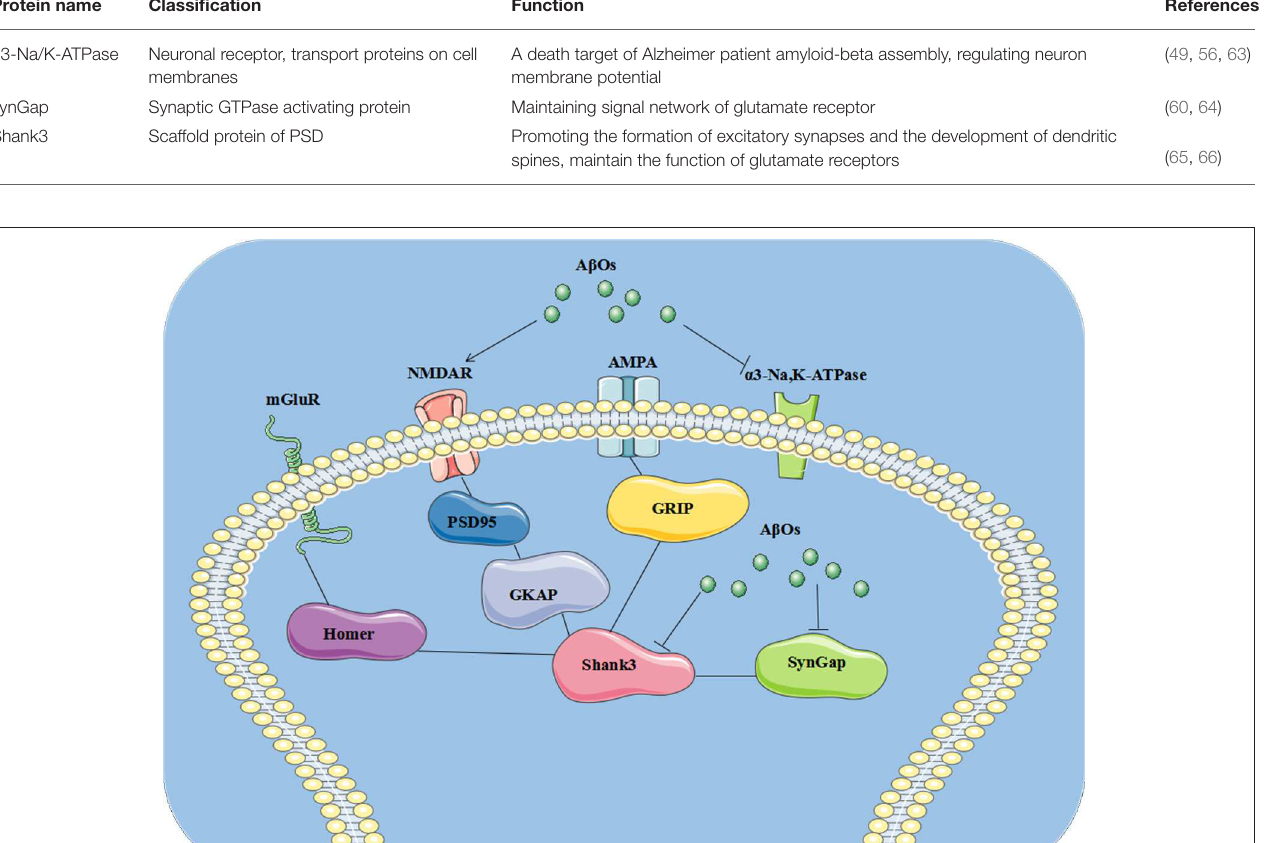
inhibit all α 1,2,3-Na/K-ATPase activity. However, we did not find soluble A β directly binding to α 1,2-Na/K-ATPase in co-IP and ligand